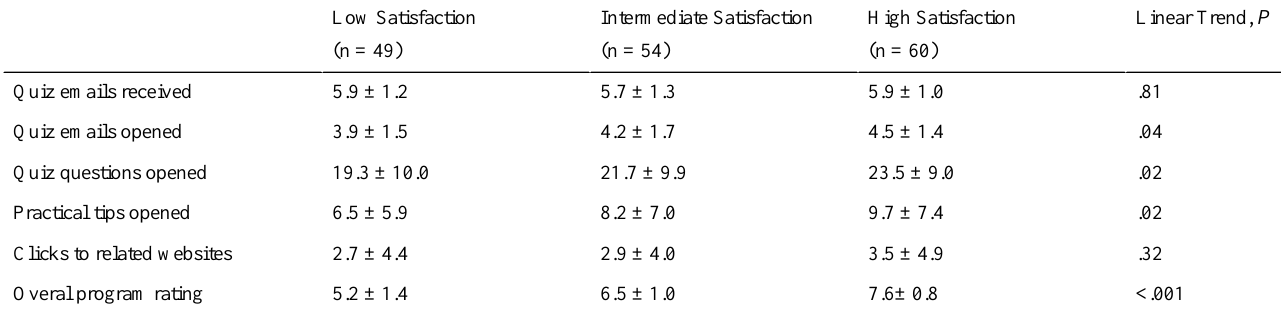
Table 4. Participation measures and program rating by user satisfaction